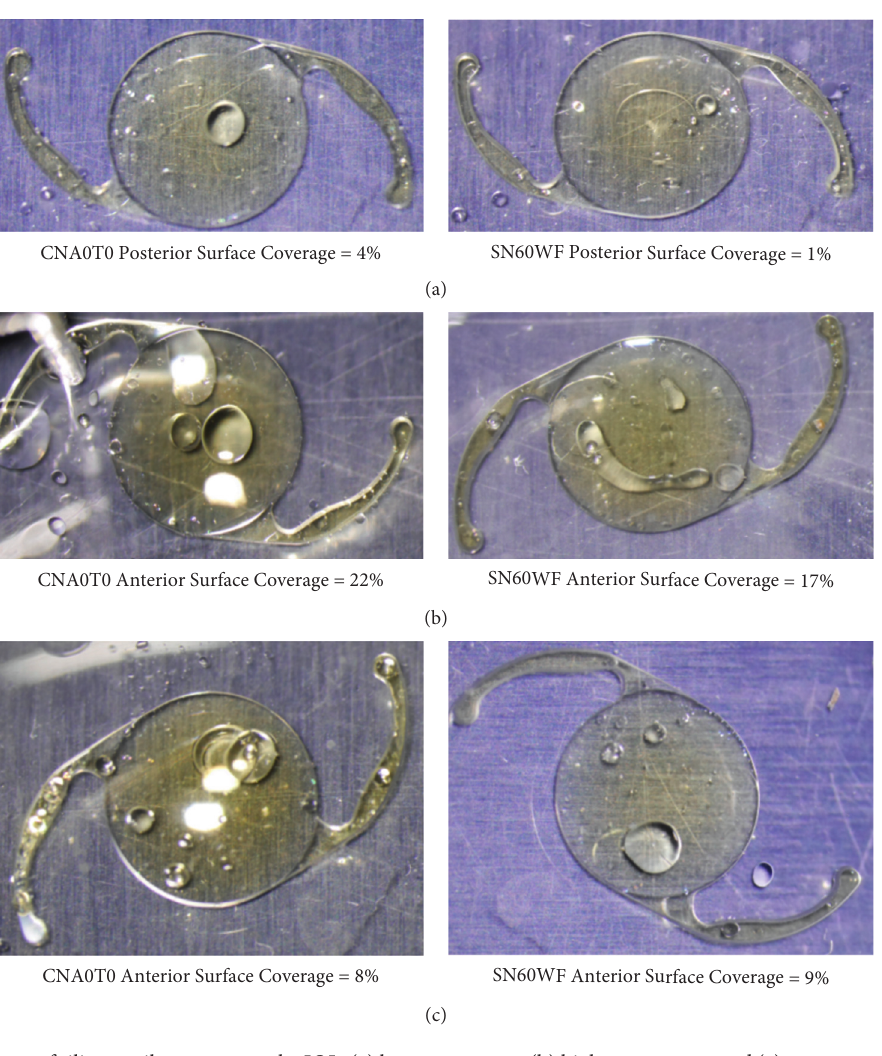
Figure 4: Digital images of silicone oil coverage on the IOL: (a) lowest coverage, (b) highest coverage, and (c) mean coverage (representative examples). IOL: intraocular